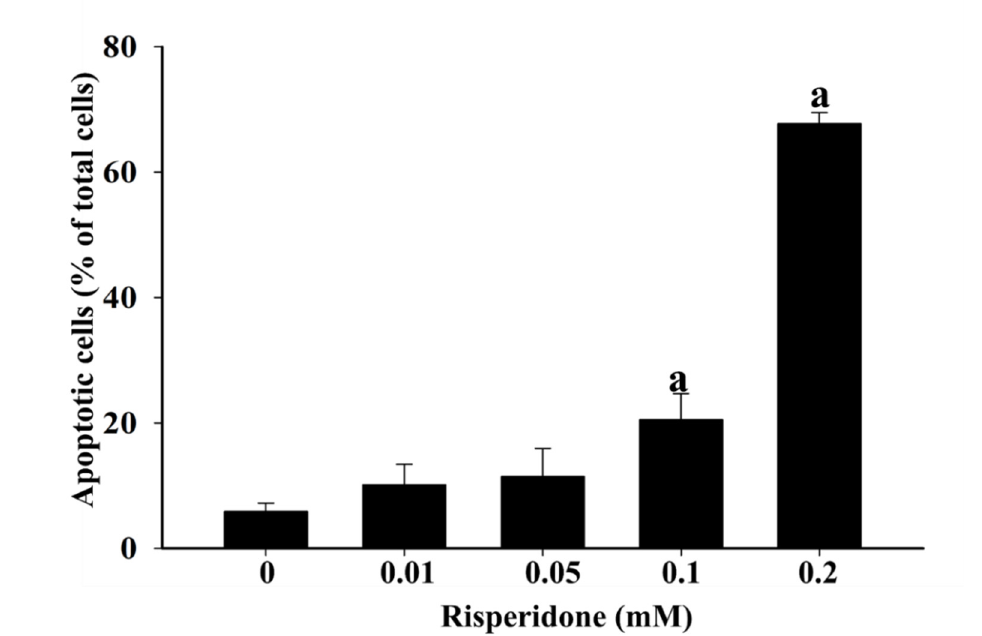
Figure 4. Apoptosis of SW480 cells in the presence of risperidone. “a” indicates a significant difference ( p < 0.05) compared with the control group. Similar results were obtained in three repeated experiments.